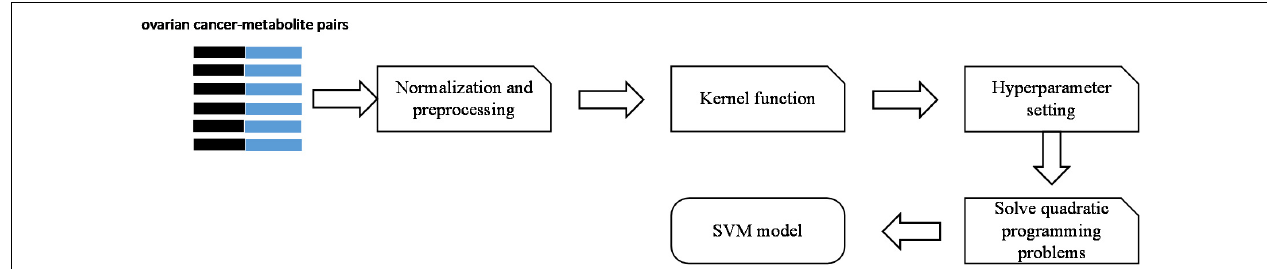
FIGURE 2 | Process of building the SVM model.